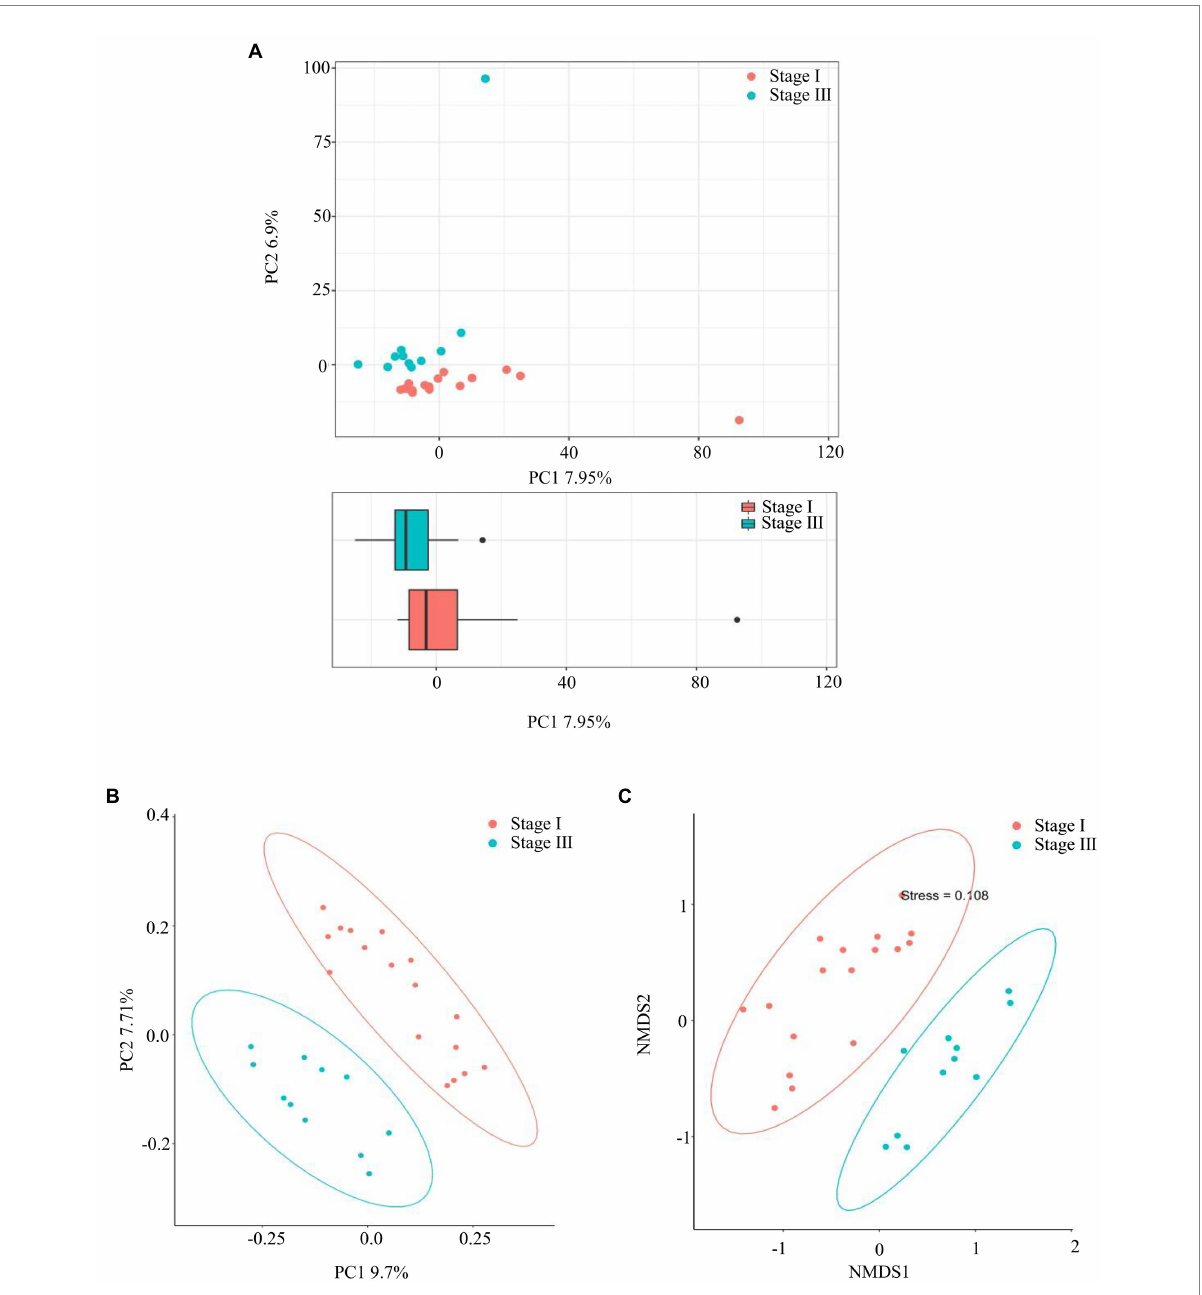
FIGURE 3 The β -diversity analysis. (A) Principal component analysis (PCA), (B) Principal coordinate analysis (PCoA) based on the Binary Jaccard distance, and (C) non-metric multidimensional scale based on the unweighted UniFrac distance, respectively, were used to analyze the similarity between microbial